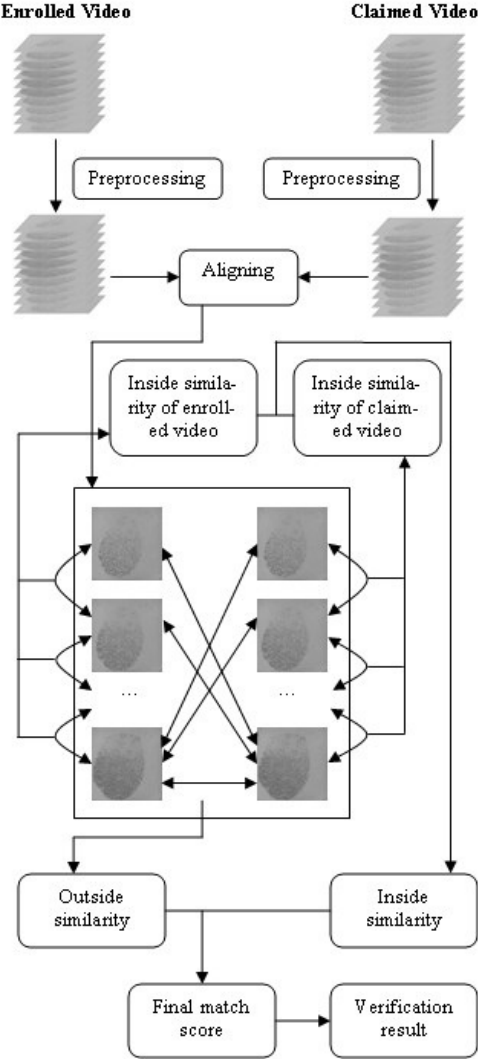
Figure 4. Flow chart of the video-based fingerprint verification